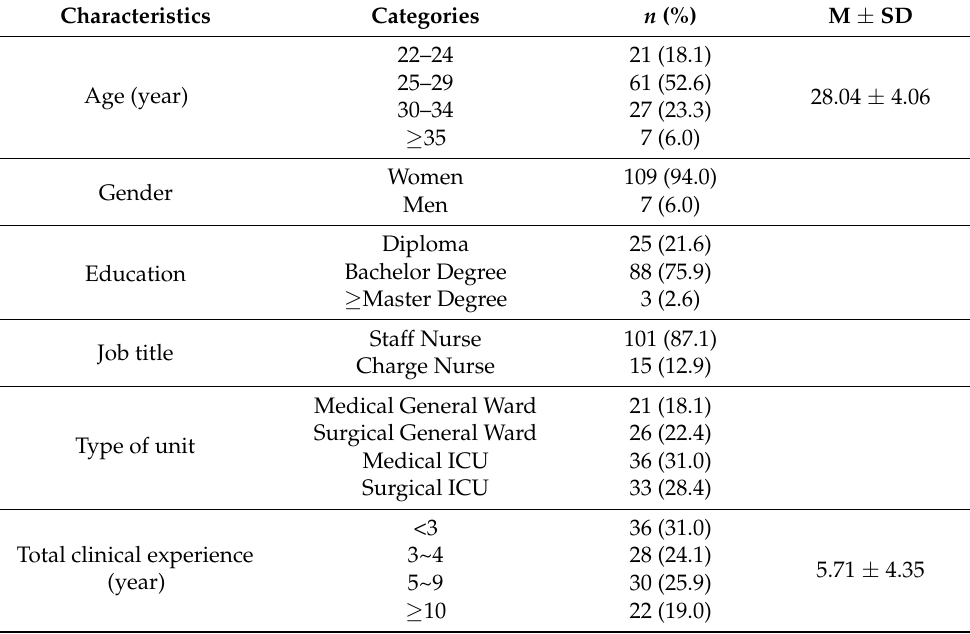
Table 1. Demographic and work-related characteristics of nurses (N = 116).